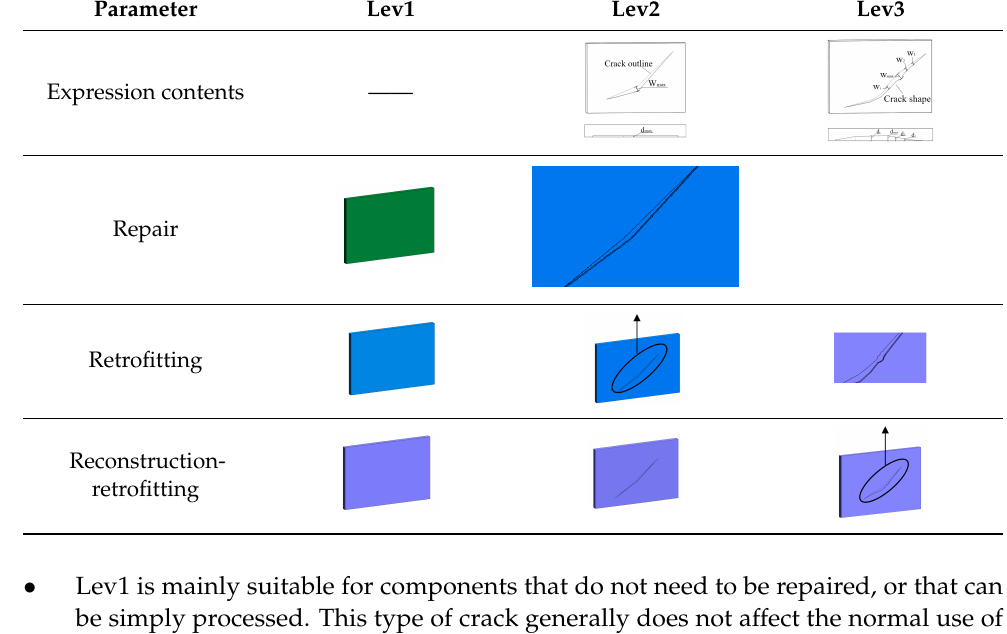
Table 1. Schematic diagram of multi-level expression of damage.